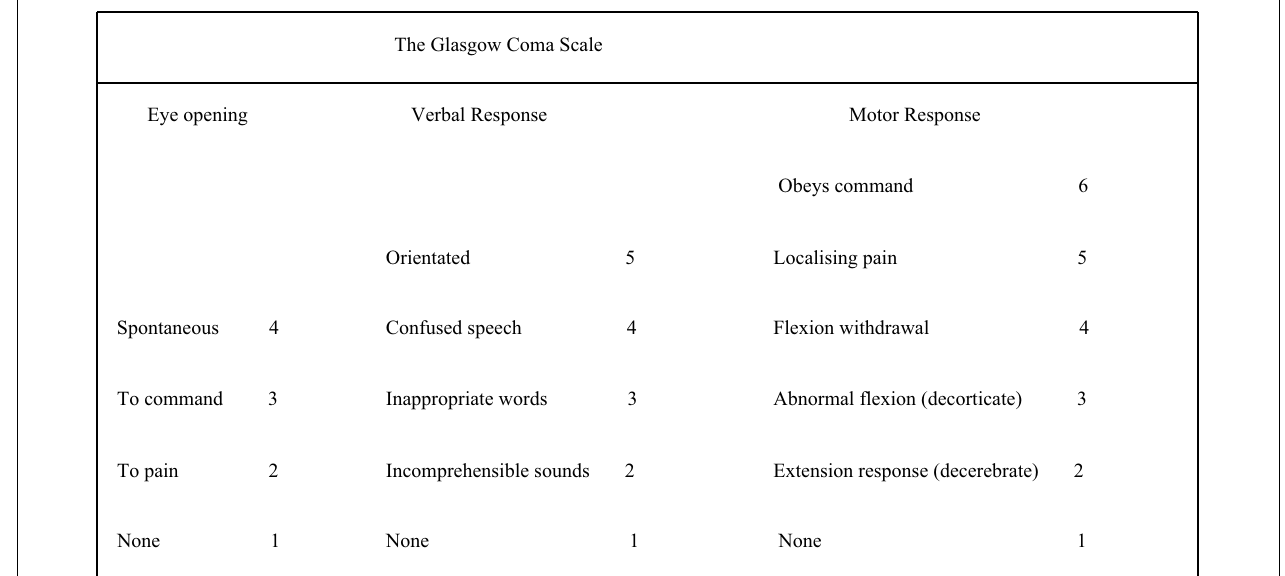
FIGURE 2 |The 15-item Glasgow Coma Scale and the scoring of the clinical variables.